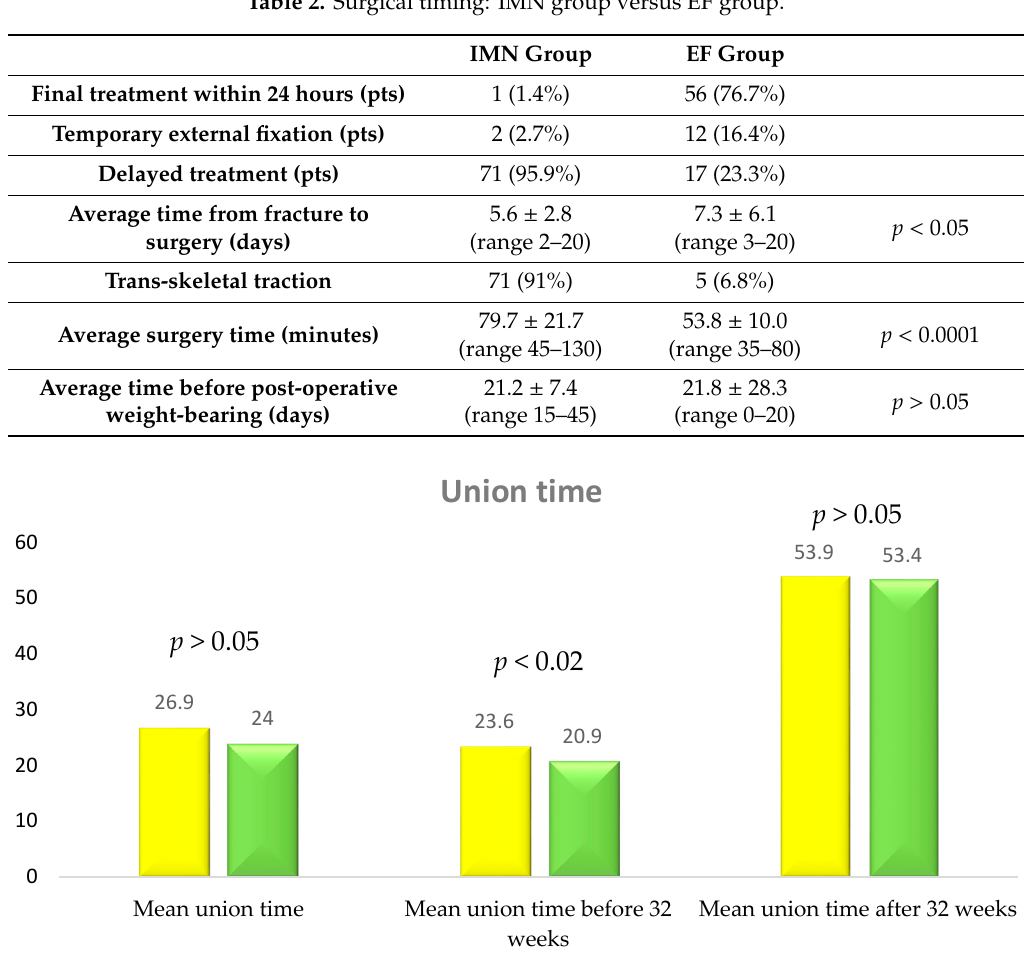
Figure 2. Union time: IMN versus EF group. Table 2. Surgical timing: IMN group versus EF group.